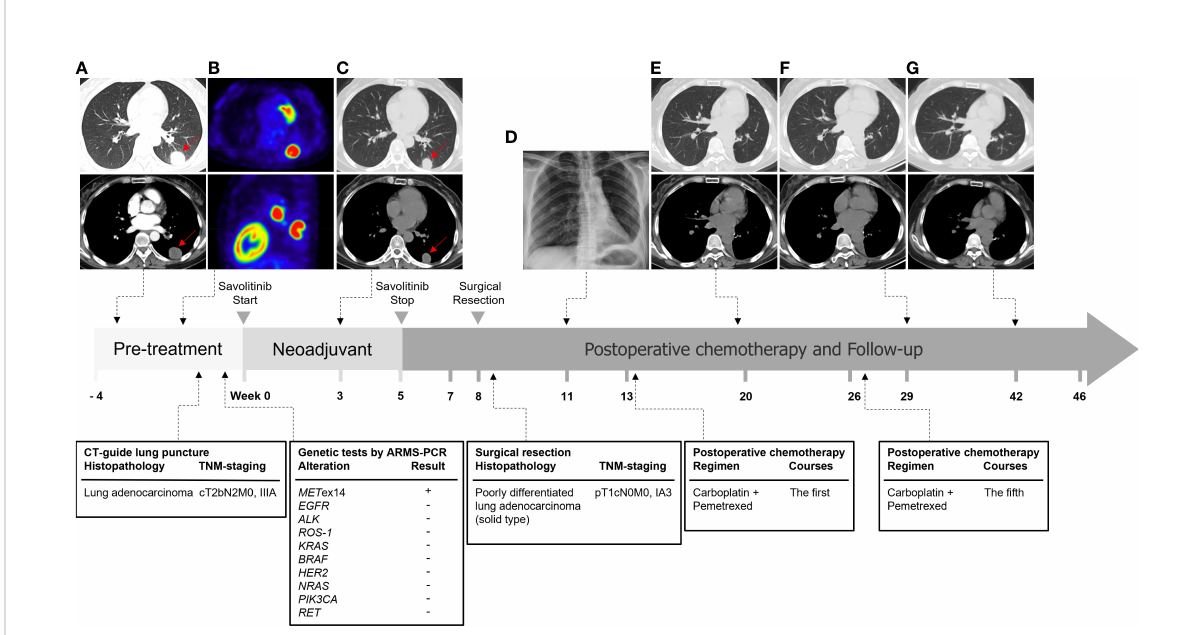
FIGURE 4 Timeline of diagnosis and treatment of this case. (A) The chest contrast-enhanced CT scan at the fi rst visit to the hospital on July 1, 2021. (B) The 18-FDG PET/CT examination on July 6, 2021. (C) The chest CT scan after 21 days (August 13, 2021) savolitinib neoadjuvant therapy. (D) Postoperative chest x-ray on October 13, 2021 revealed good lung expansion of left lung. (E – G) The patients underwent re-examination of chest CT on December 20, 2021, March 2, 2022, and June 3, 2022 respectively, which showed postoperative changes and no signs of